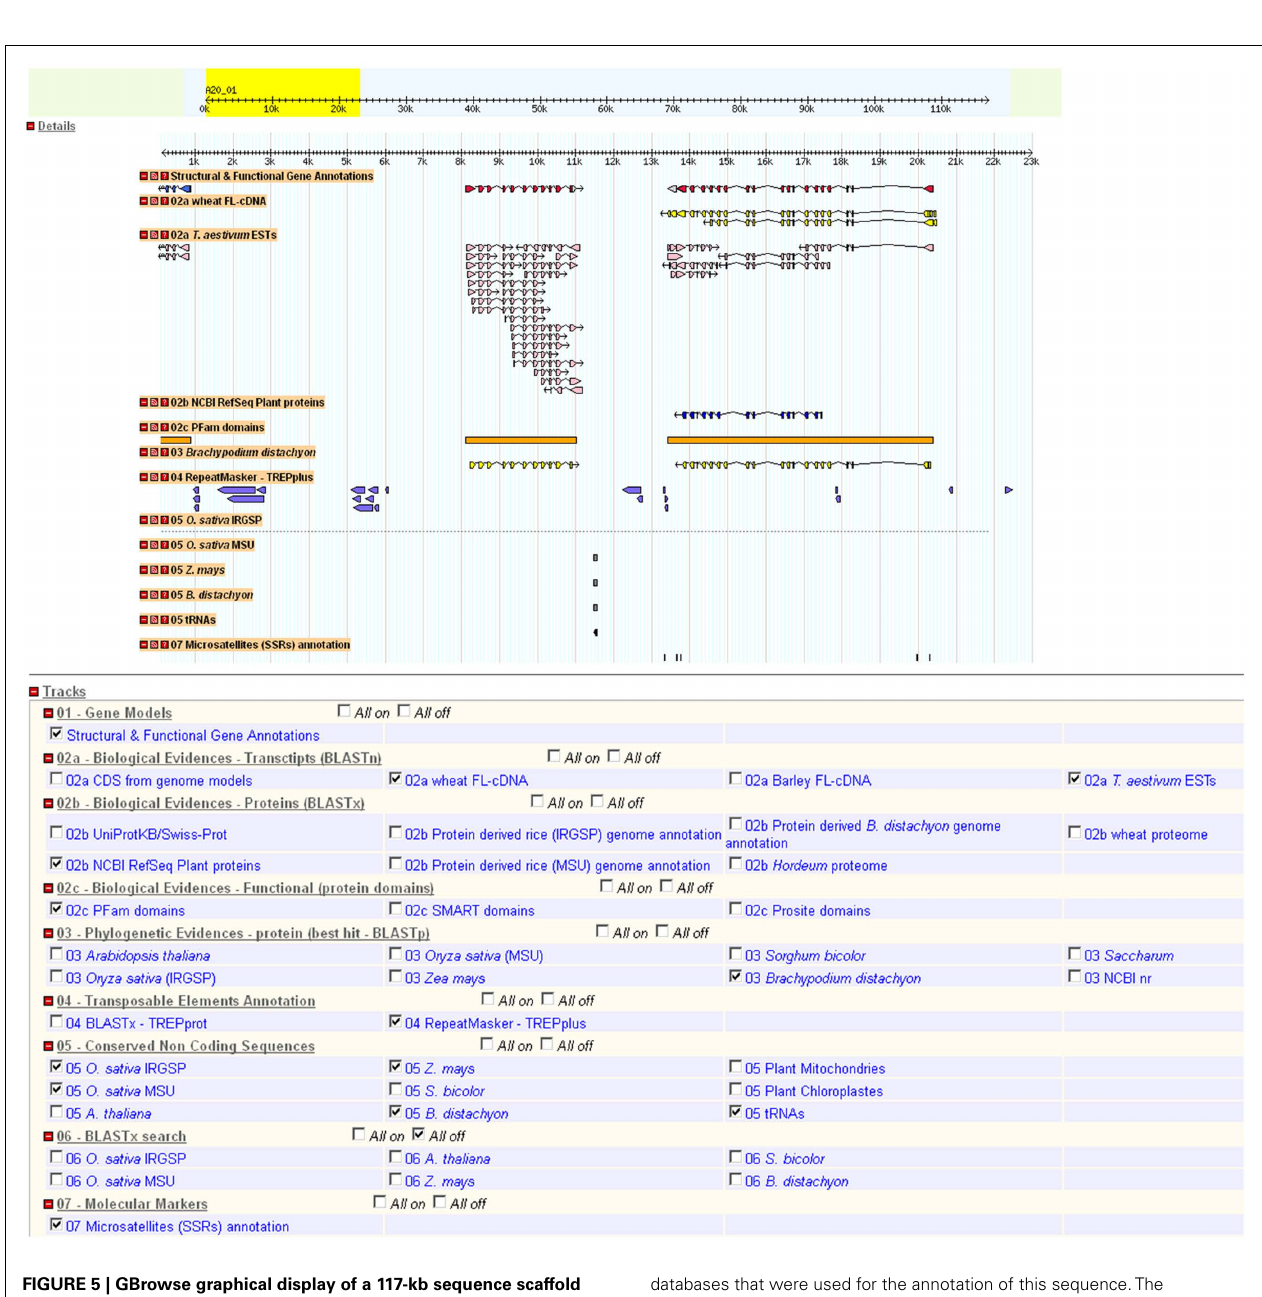
FIGURE 5 | GBrowse graphical display of a 117-kb sequence scaffold from the wheat chromosome 3B. The upper part shows the sequence and the window corresponding to the region for which annotation features are displayed in the central part.The bottom part presents the different databases that are used for the annotation.The ticked boxes indicate the